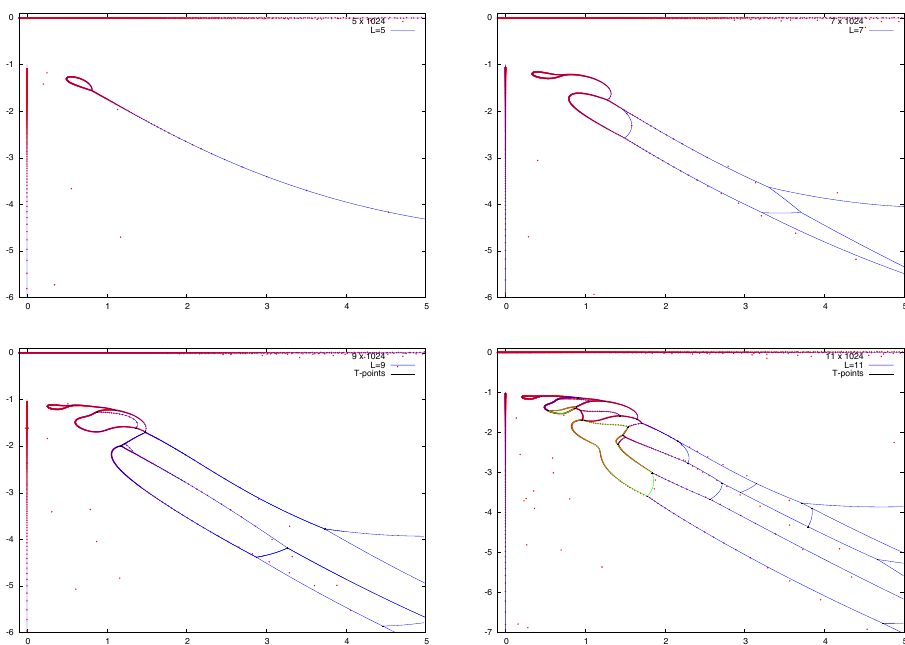
Figure 7 . Comparison between the partition function zeros on a (2 M + 1) (cid:2) 2 N cylinder, with N = 1024, and the corresponding condensation curves in the N ! 1 limit (open channel). The panels show, in reading direction, the cases M = 2 ; 3 ; 4 ;